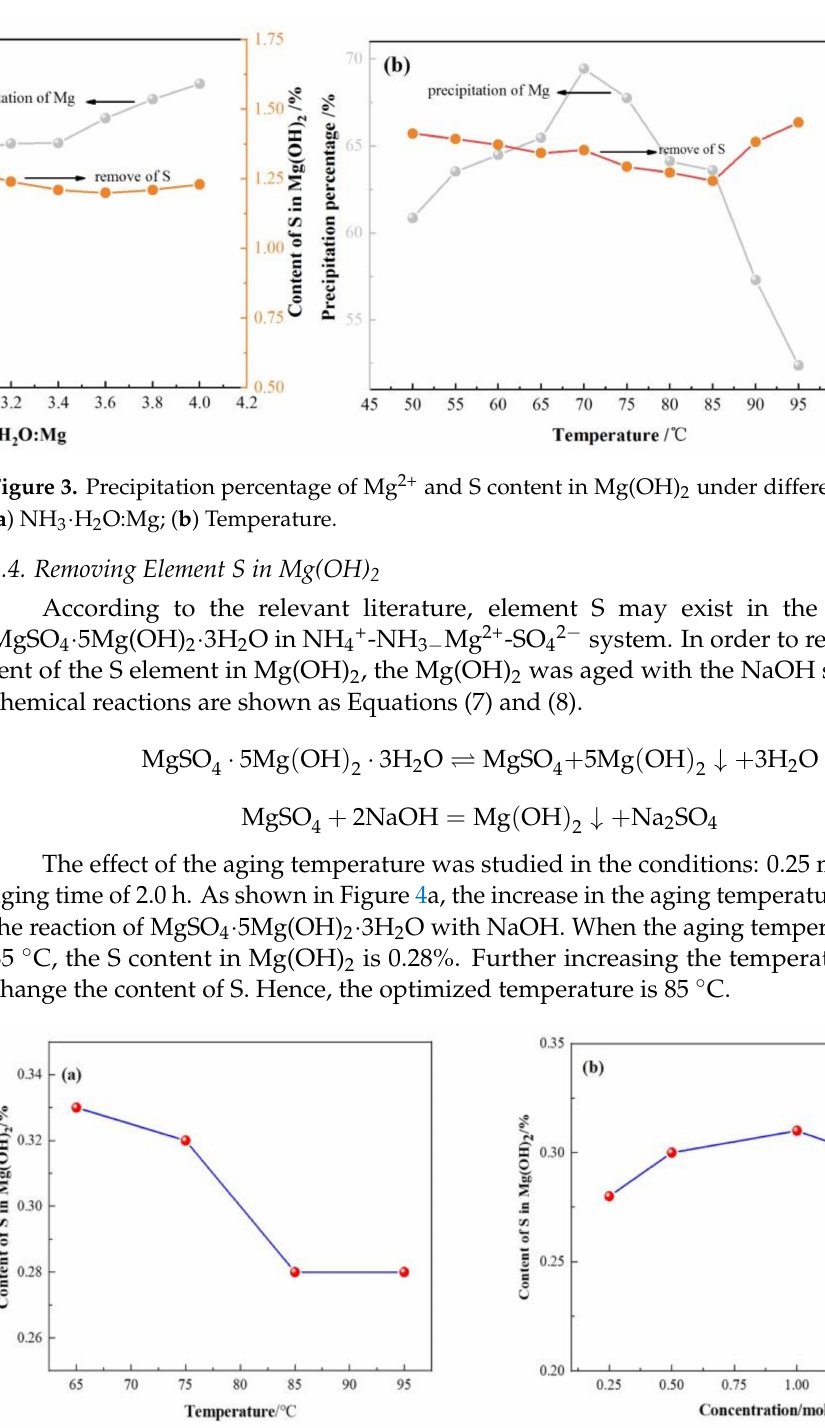
Figure 4. Influence of different aging conditions on the effect of S removal. ( a ) Temperature; ( b )